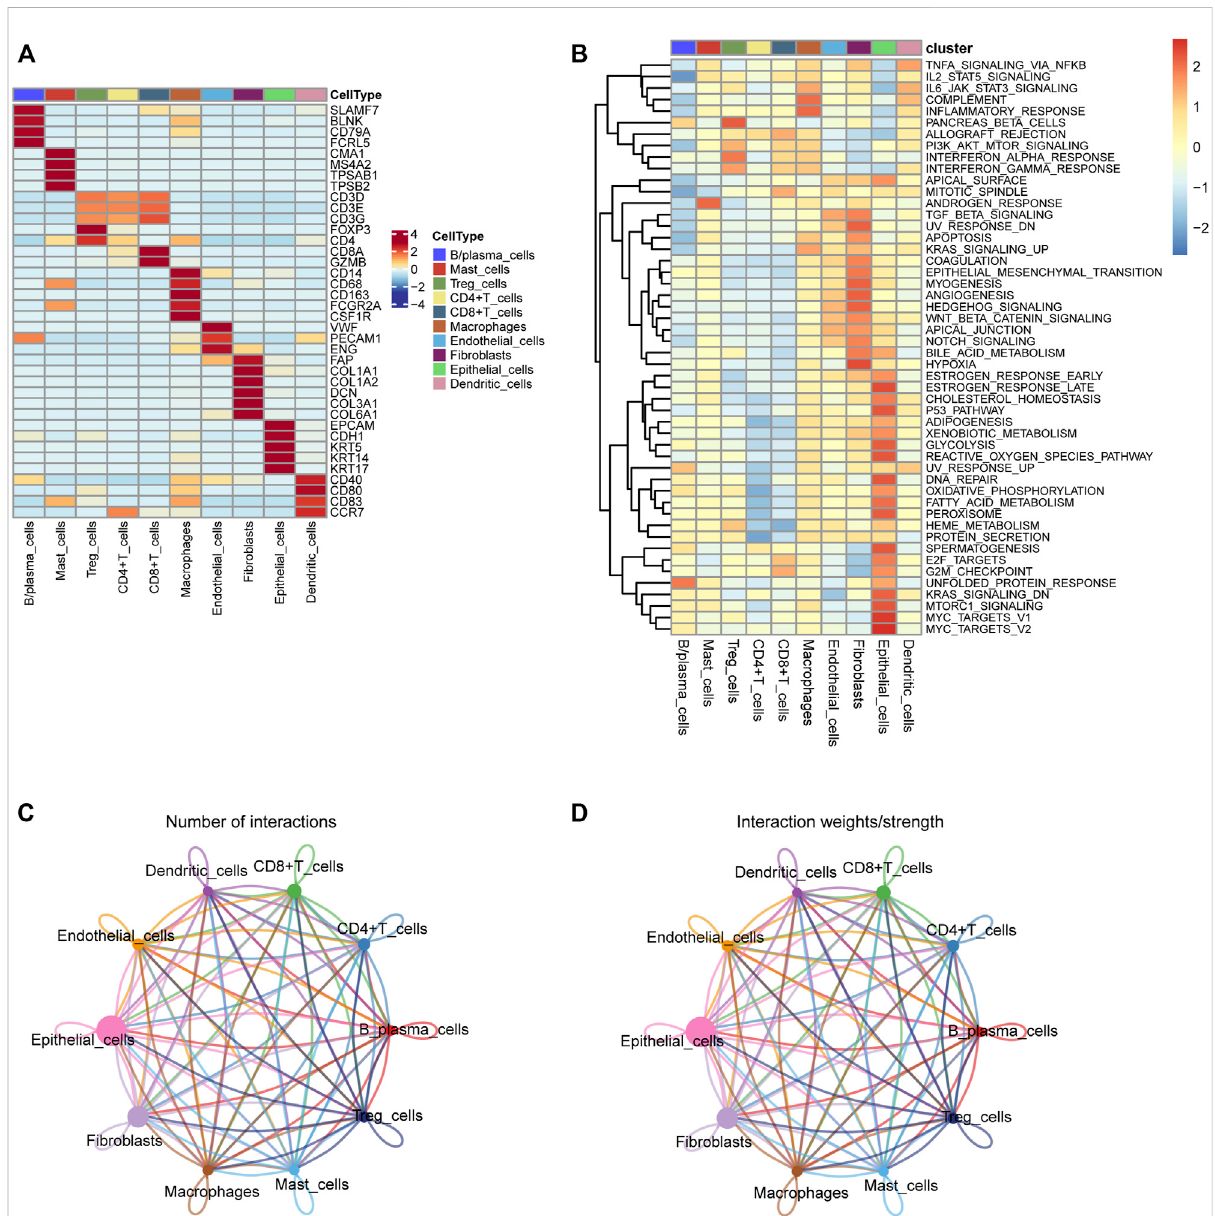
dimension reduction. Next, diverse cell types, B/plasma cells,